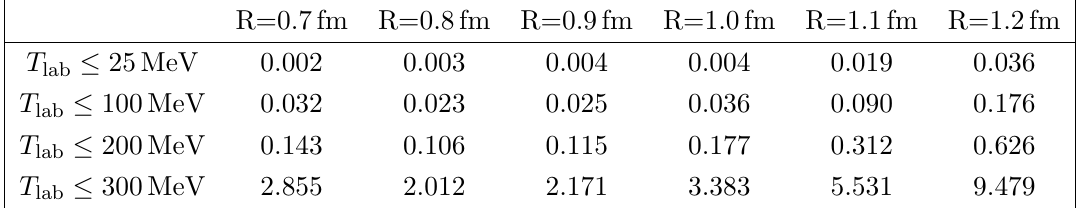
Table 1 . Resulting e(cid:11)ective ~ (cid:31) 2 (see text) for di(cid:11)erent cuto(cid:11)s R and di(cid:11)erent energy